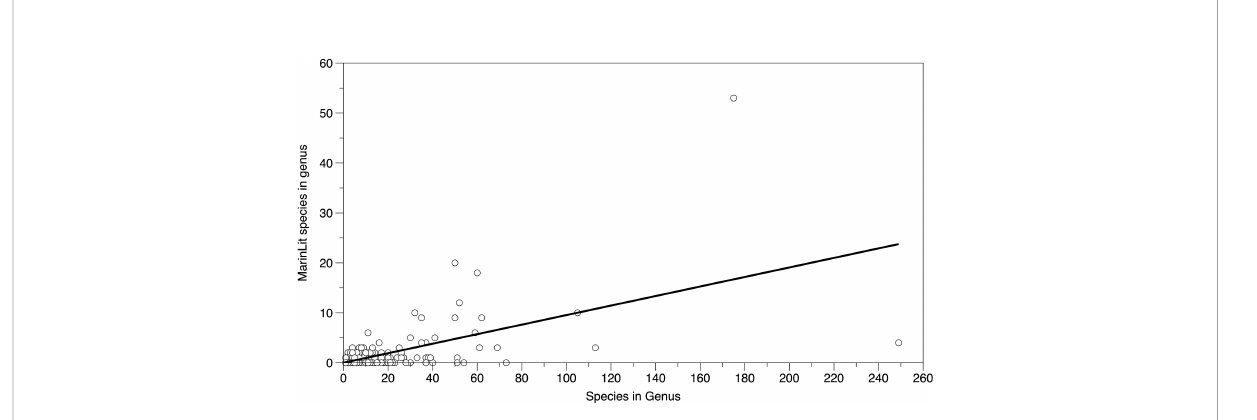
FIGURE 1 Number of species with at least one MarinLit compound recorded in different cnidarian genera. Fitted line is a regression passing through the origin (r 2 39.5%).